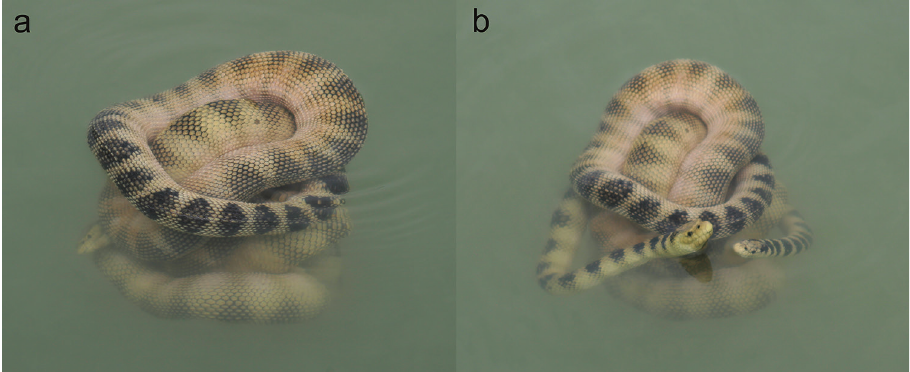
Figure 20. Two Hydrophis cyanocinctus intertwined each other and floating on the surface in a mangrove channel in Jask (western Gulf of